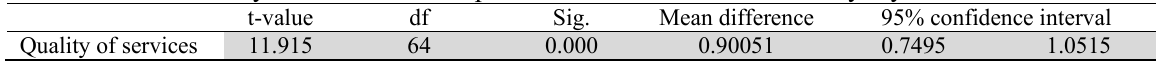
The results of one-way test on relationship between CRM and customer loyalty t-value df Sig. Mean difference 95% confidence interval Quality of services